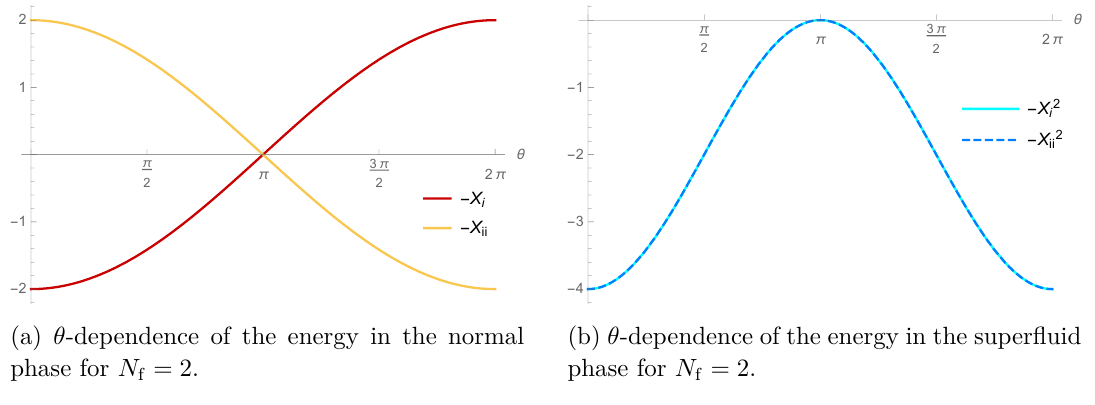
Figure 1 . θ -dependence of the energy for N f = 2